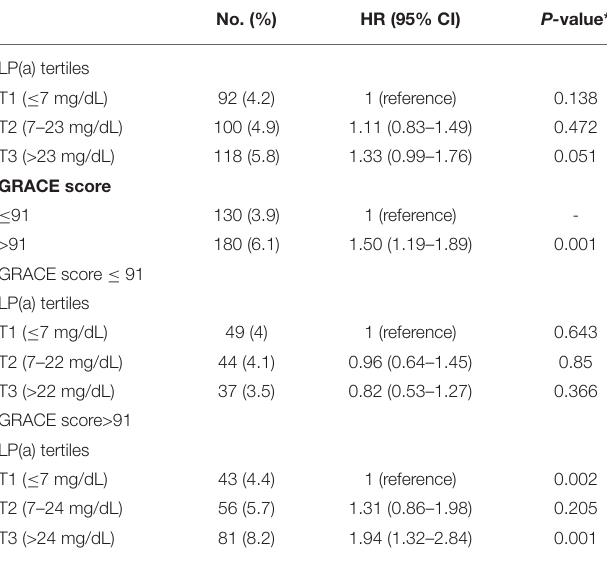
TABLE 2 | Risk of cardiovascular events according to lipoprotein(a) and GRACE score.